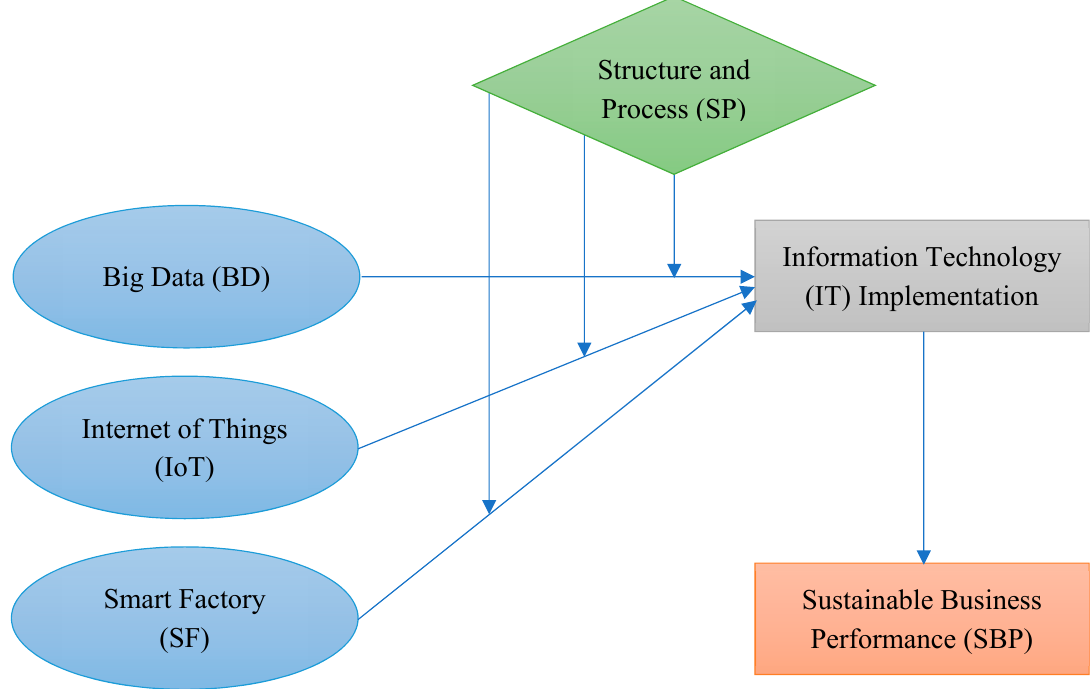
Figure 5. Theoretical framework of the study showing the contribution of Industry 4.0 towards sustainable business performance.